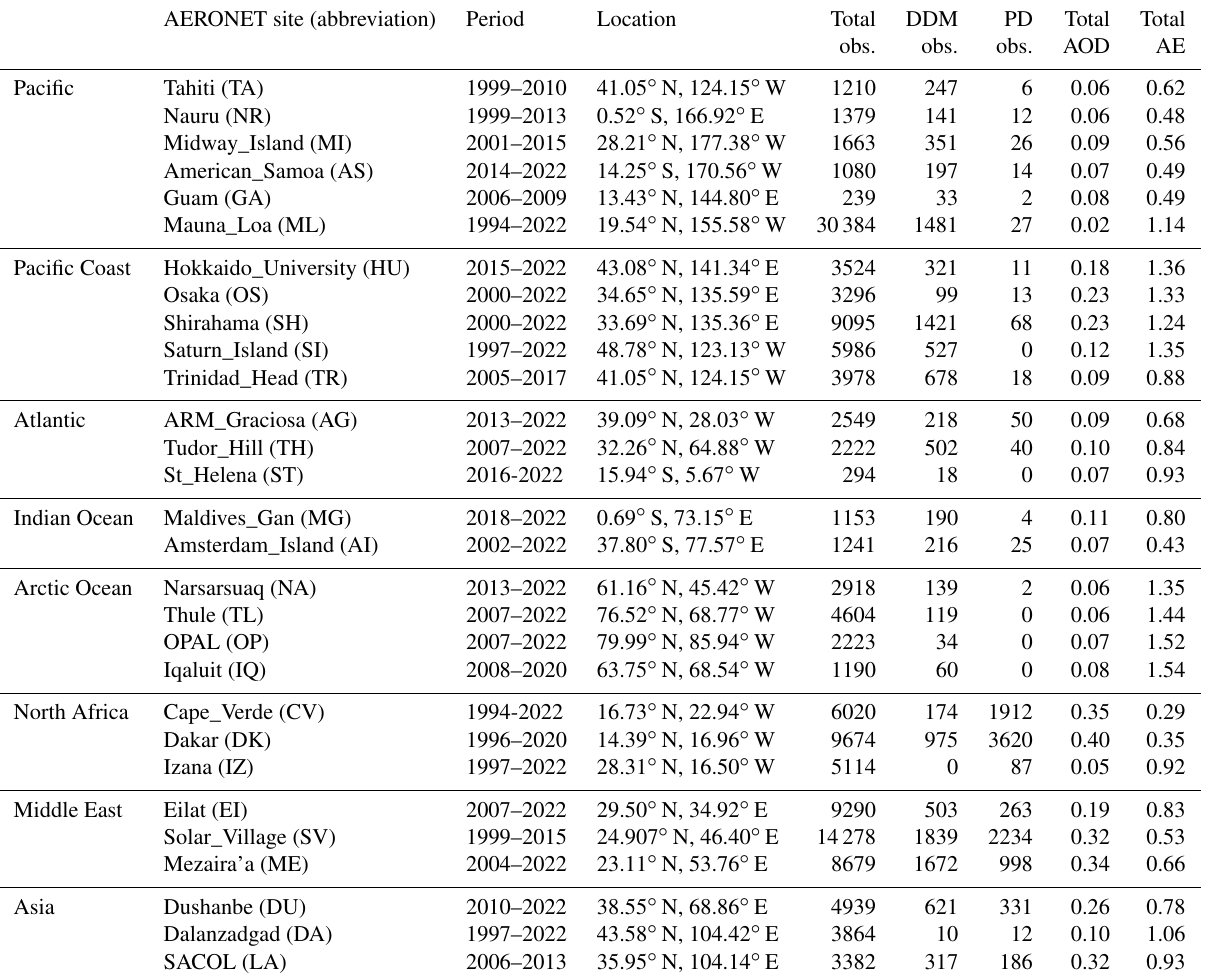
Table 2. Basic information of the AERONET sites selected for dust-related POLIPHON conversion factor calculation near the deserts (from North Africa, the Middle East, and Asia) and over the ocean and coast (from the Pacific, Pacific coast, Atlantic, Indian Ocean, and Arctic Ocean) regions, including the site name and abbreviation, period, and location. The available number of data points for total, dust-dominated mixture (DDM), and pure dust (PD) observations in AERONET Version 3 aerosol inversion products (level 2.0 for near-desert cluster and level 1.5 for oceanic and coastal cluster) are also given, respectively. Average AODs at 532nm (AOD) and Ångström exponents between 440 and 870nm (AE) at each site are